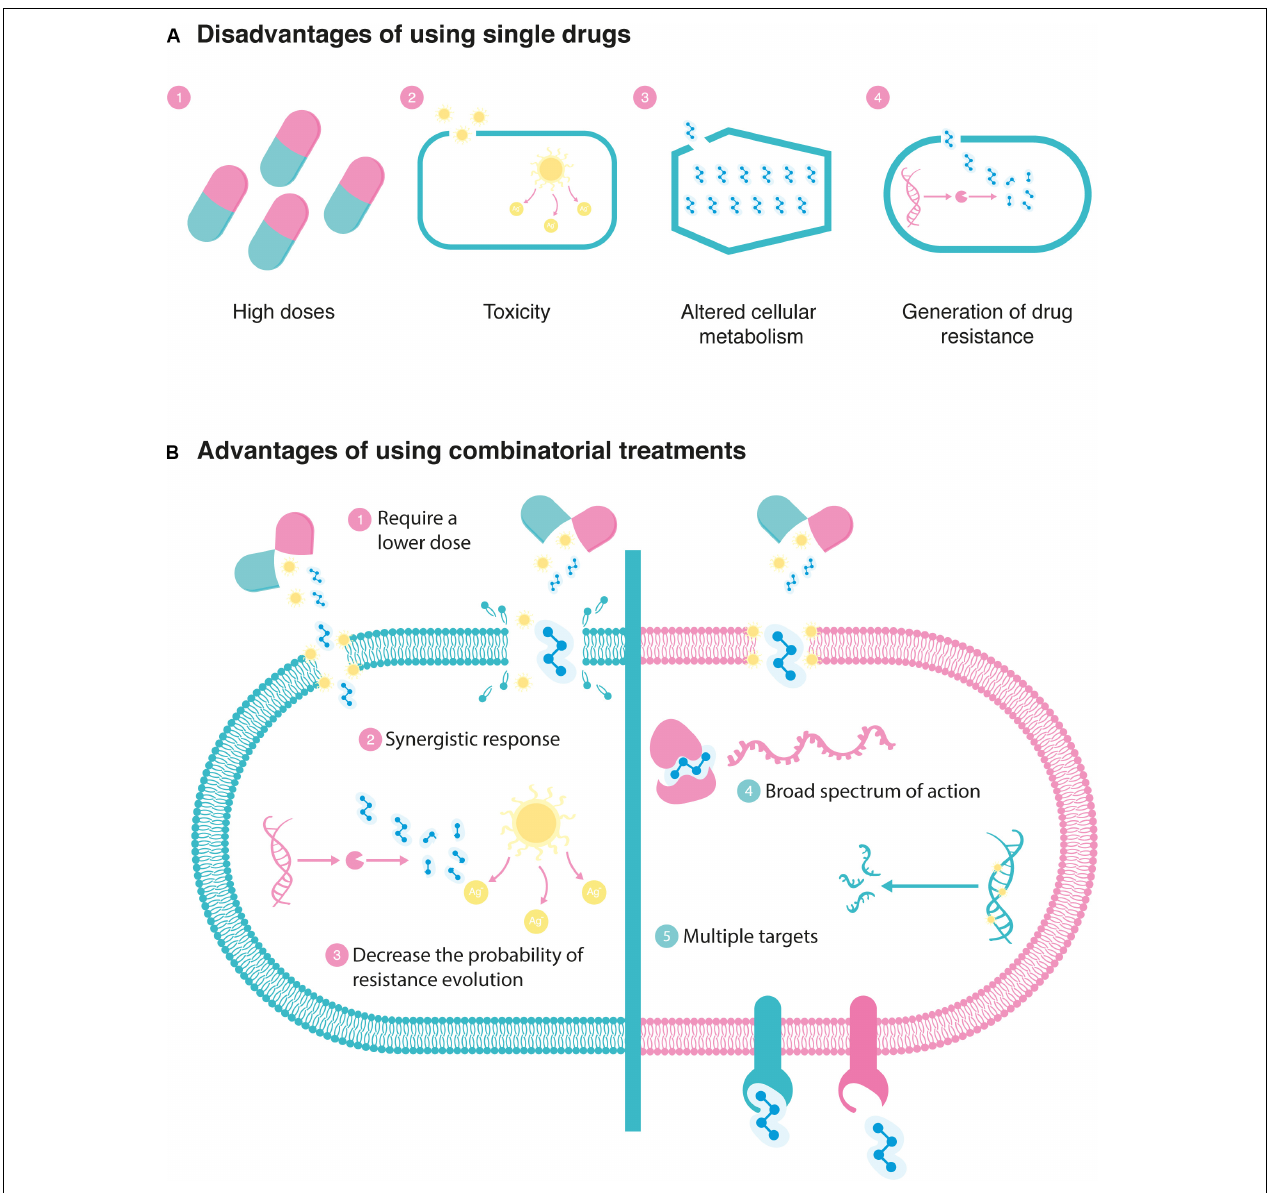
FIGURE 2 | Antimicrobial treatment strategies: (A) disadvantages of using single drugs and (B) advantages of using combinatorial treatments. The advantage of using combinatorial treatments of synergistic drug pairs provides the opportunity to lower the dosage of the individual agents, thereby reducing toxicity while maintaining the wanted effect on bacteria. Moreover, a synergistic response can occur because of complementary drug action (multiple targets sites on the same protein or pathway are hit; Pemovska et al., 2018). By combining two drugs that achieve the same effect through different mechanisms of action, the development of resistance to a single drug in the combination may be less likely to occur, and when it does occur, it may have a lower impact on the therapeutic outcome (Pirrone et al., 2011). Finally, the use of more than one agent broadens the antibacterial spectrum of the empirical therapy and thus ensures that at least one agent will cover the infecting organism (Gurjar et al.,